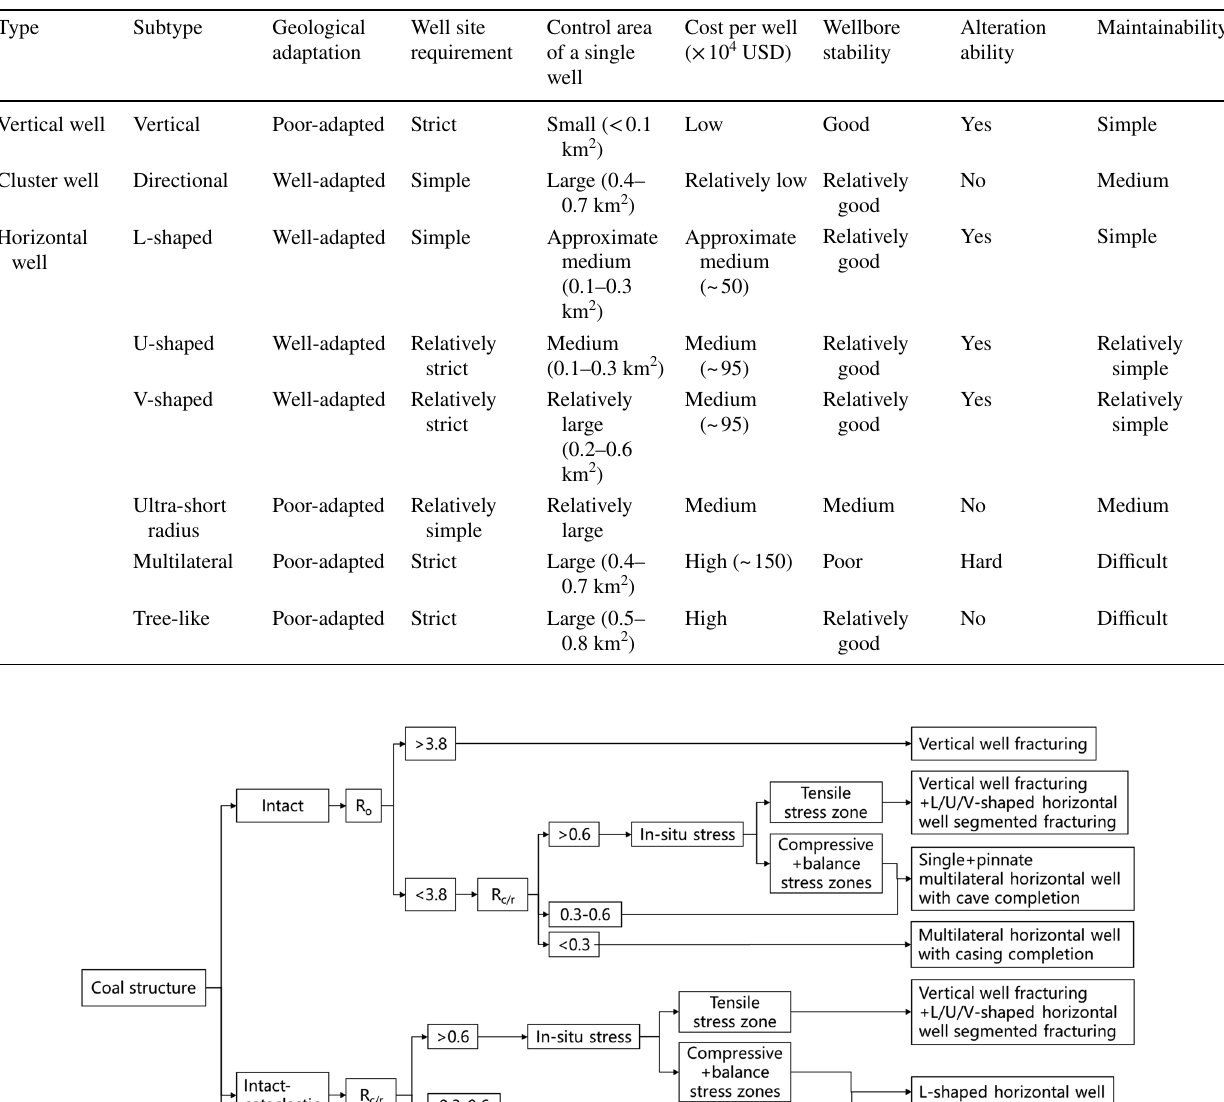
Table 2 Comparison of different CBM well types, after Shen et al. 2017 and Tao et al. 2019 Type